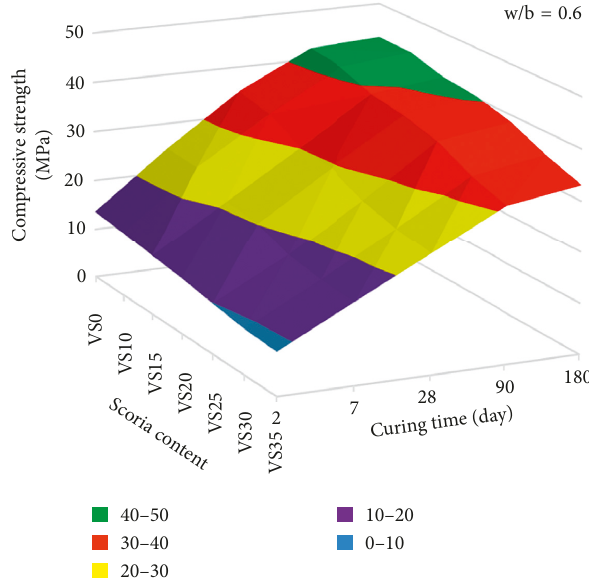
Figure 8: Development of compressive strength of VS-based binder concretes with curing ages at w/b � 0.6.